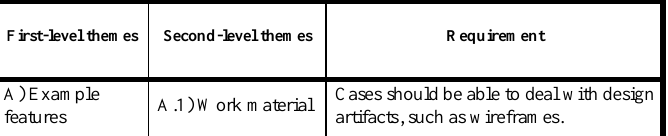
C ODING TEMPLATE CREATED AFTER ANALYZING THE INTERVIEWS , INCLUDING THE REQUIREMENTS ASSOCIATED WITH EACH THEME . First-level